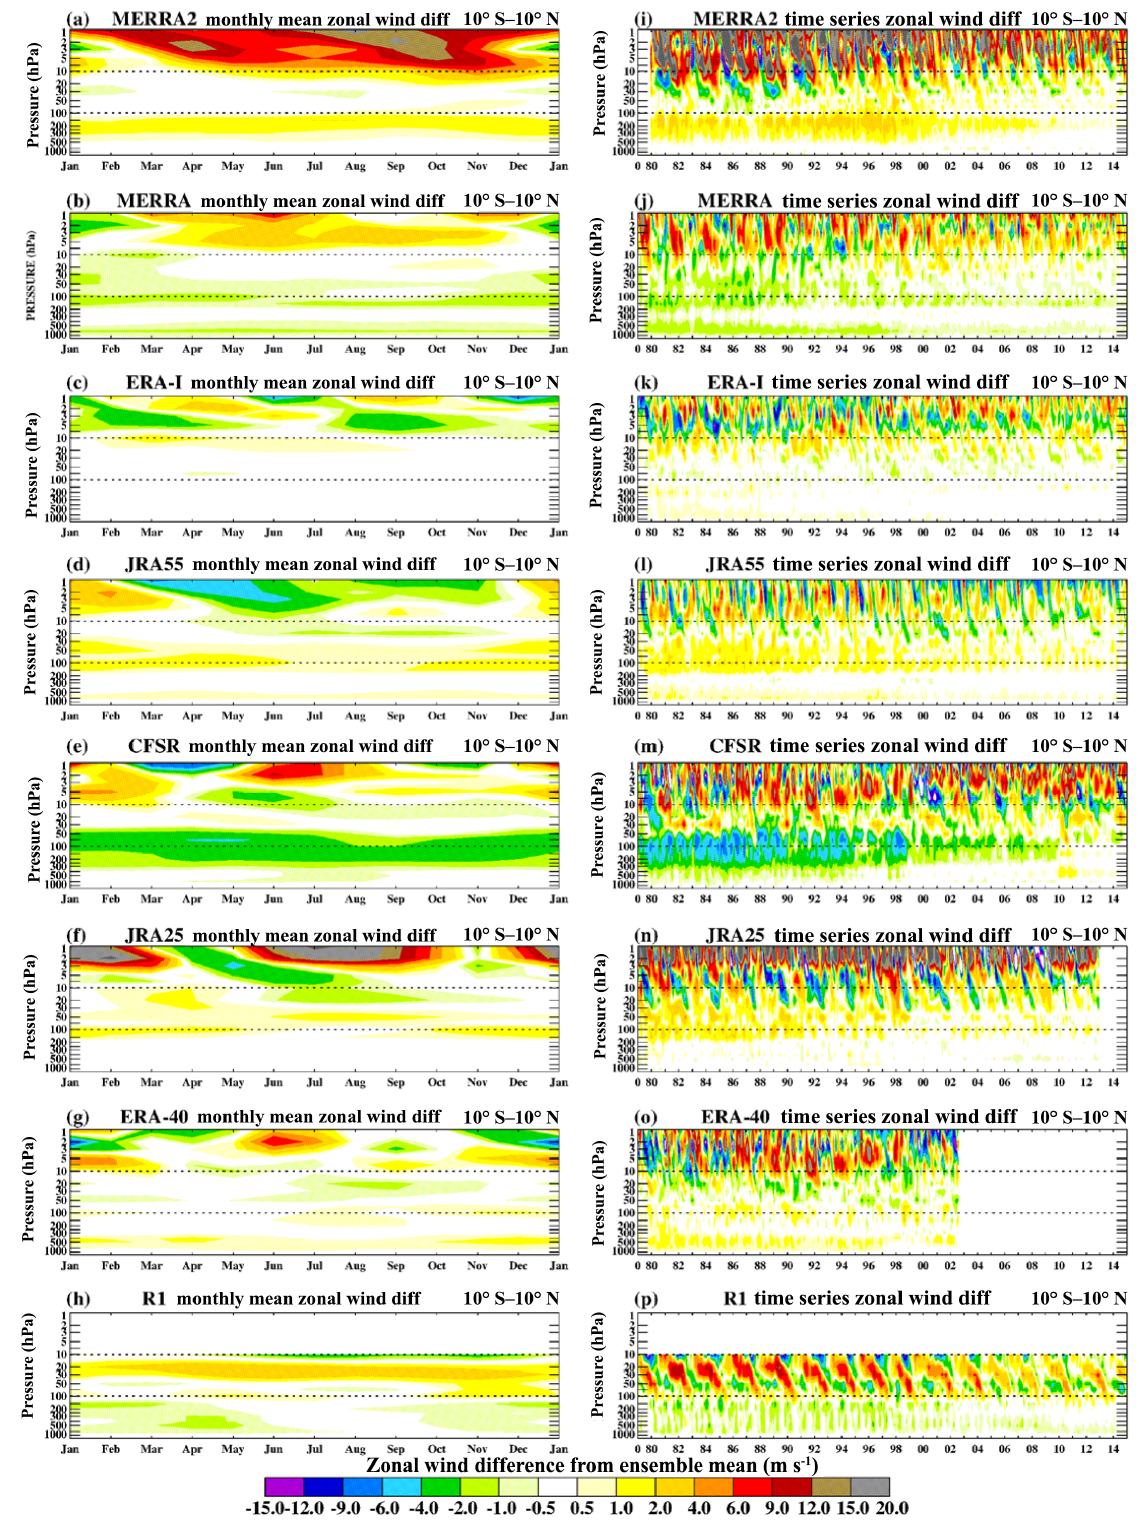
Figure 9. Pressure vs. month plots (a–h) and pressure vs. time plots (i–p) of the zonal wind difference (ms − 1 ) in individual reanalyses from the REM for the zonal region 10 ◦ S–10 ◦ N. The reanalyses are (a, i) MERRA-2, (b, j) MERRA, (c, k) ERA-I, (d, l) JRA-55, (e, m) CFSR, (f, n) JRA-25, (g, o) ERA-40, and (h, p)